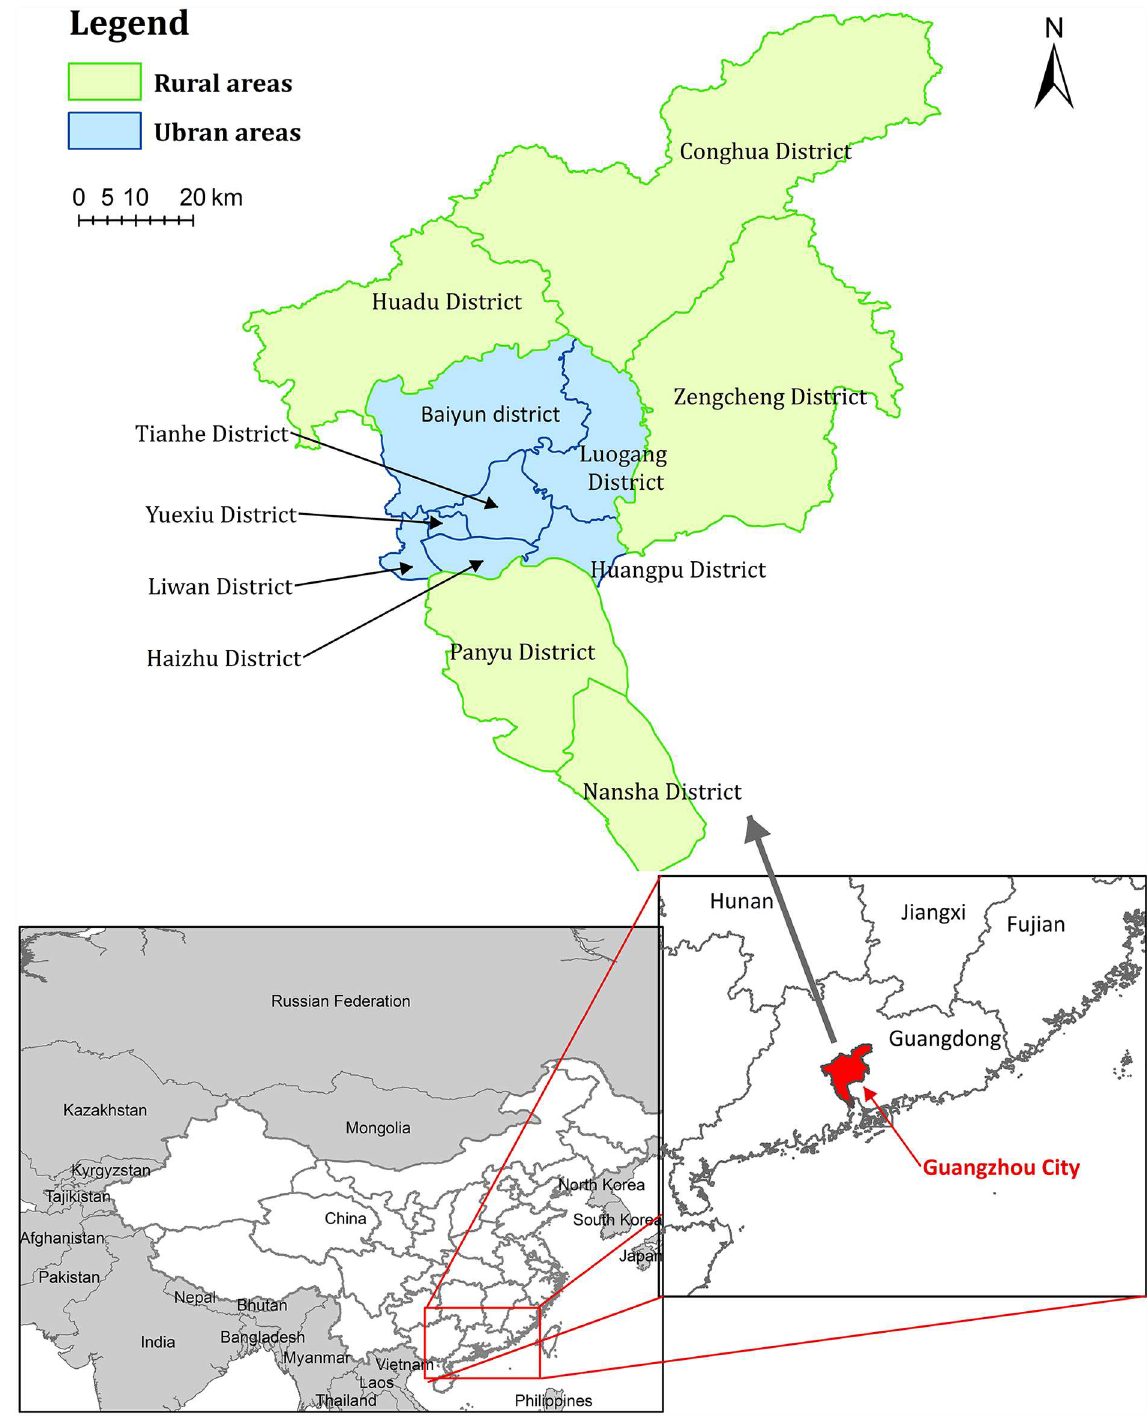
Fig 1. Geographic location of Guangzhou city, Guangdong province,